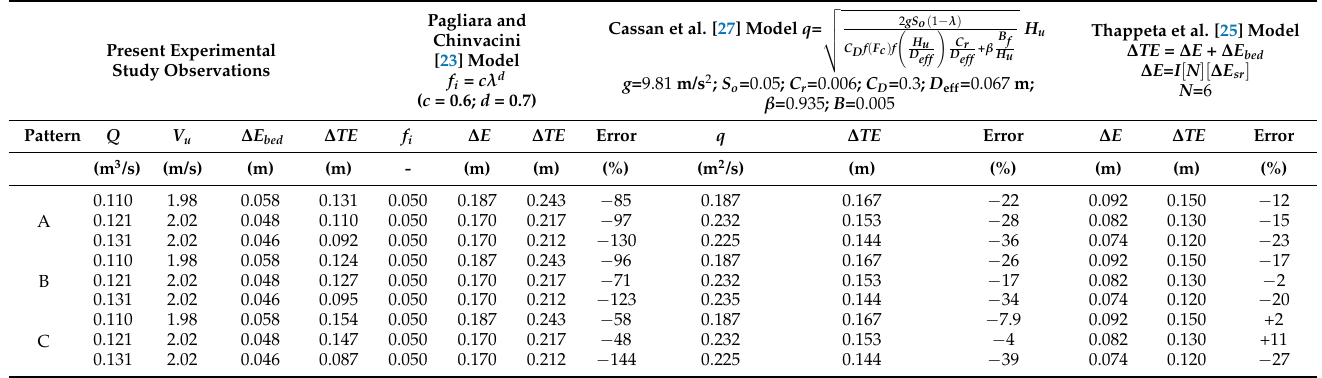
Table 3. Comparison of total head loss ( ∆ TE ) with the models reported in the